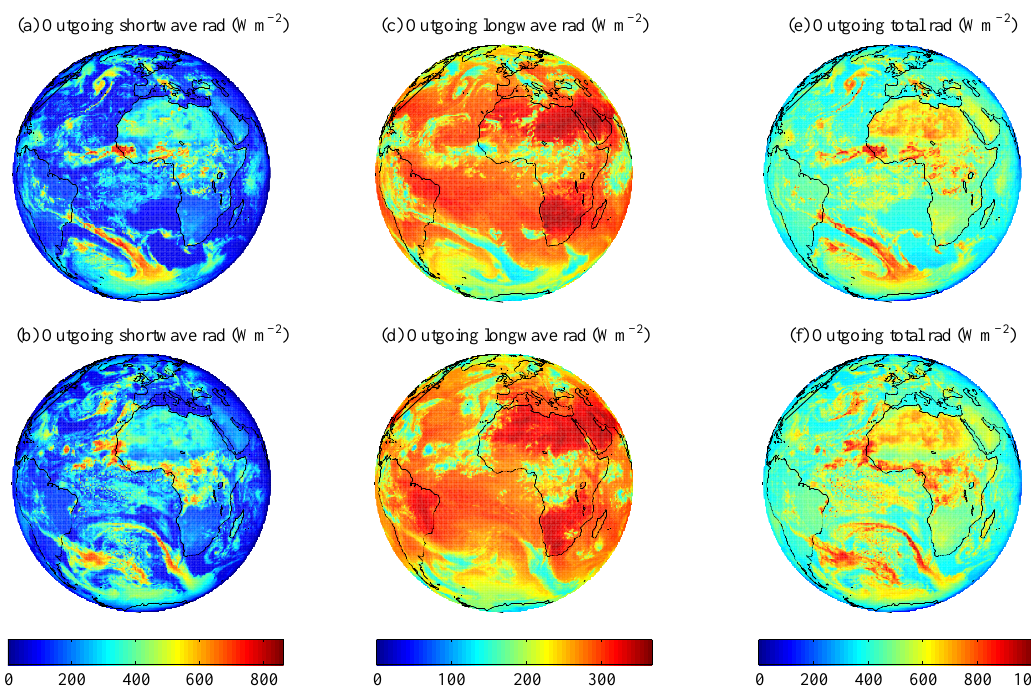
Figure 2. Outgoing shortwave radiation for ( a ) the operational run and ( b ) the Nature Run; outgoing longwave radiation for ( c ) the operational run and ( d ) the Nature Run; outgoing total radiation for ( e ) the operational run and ( f ) the Nature Run; all panels are valid at 1200 UTC on 25 September 2006 and from the perspective of the L1 Lagrange point at this